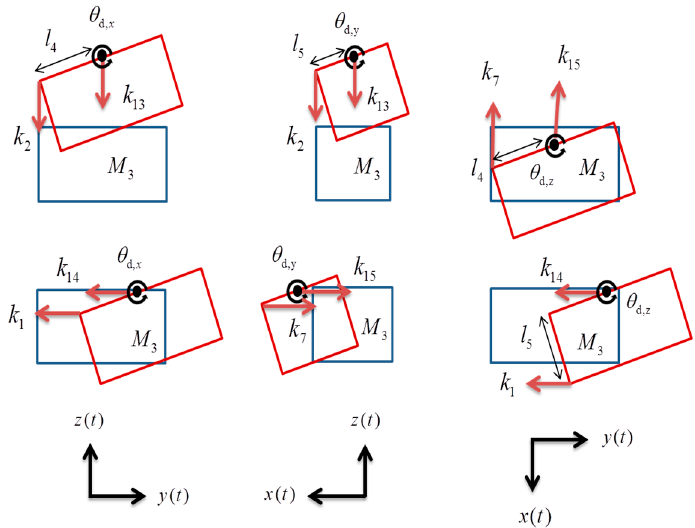
Figure 4. Free-body diagrams of the bracket unit.